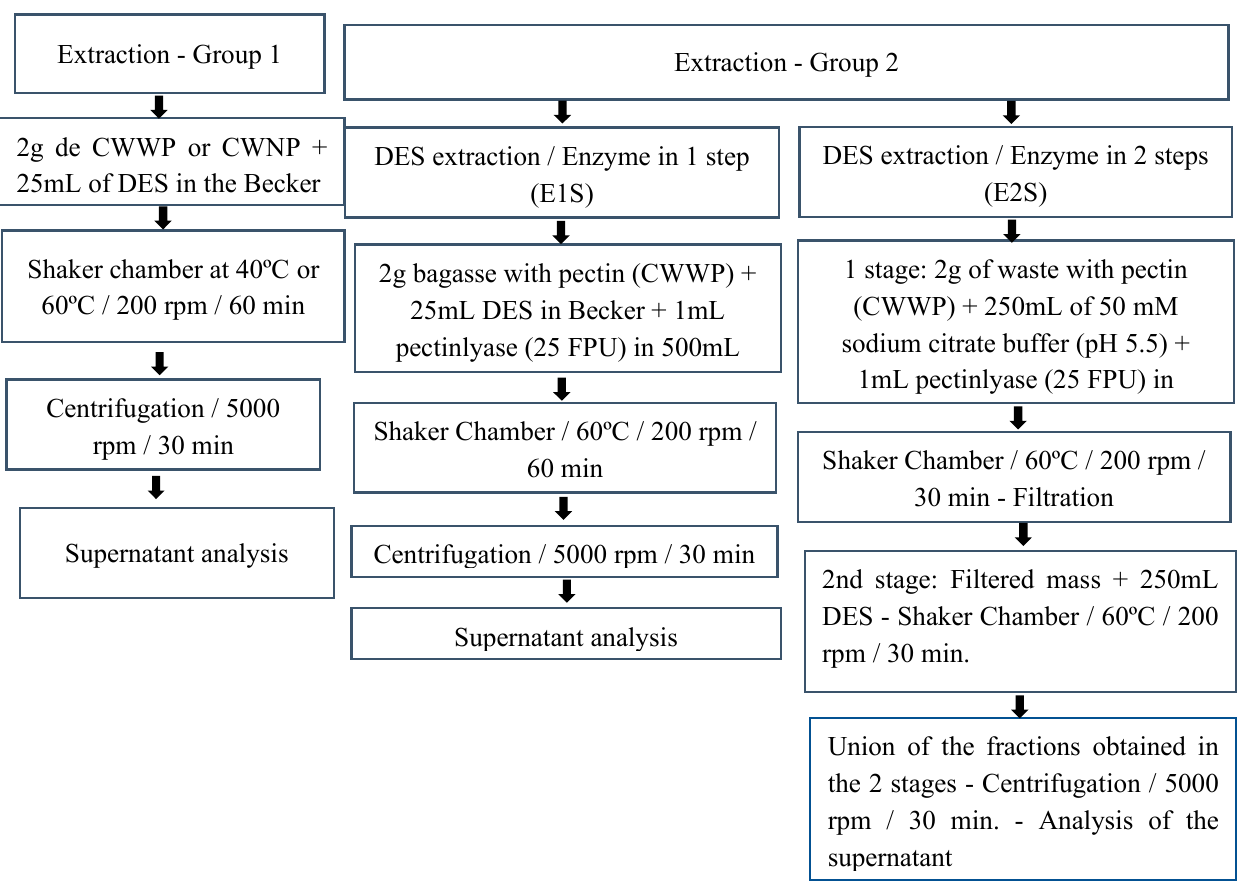
Figure 1. Scheme of extractions performed.